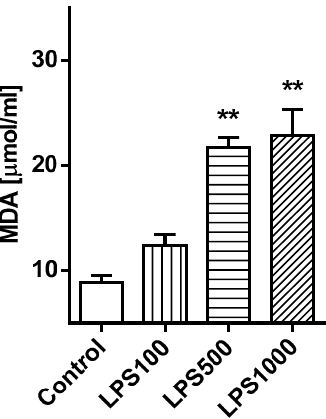
Figure 3. The values of malondialdehyde (MDA) in lung tissue. Control vs. LPS-treated groups ** p < 0.01.